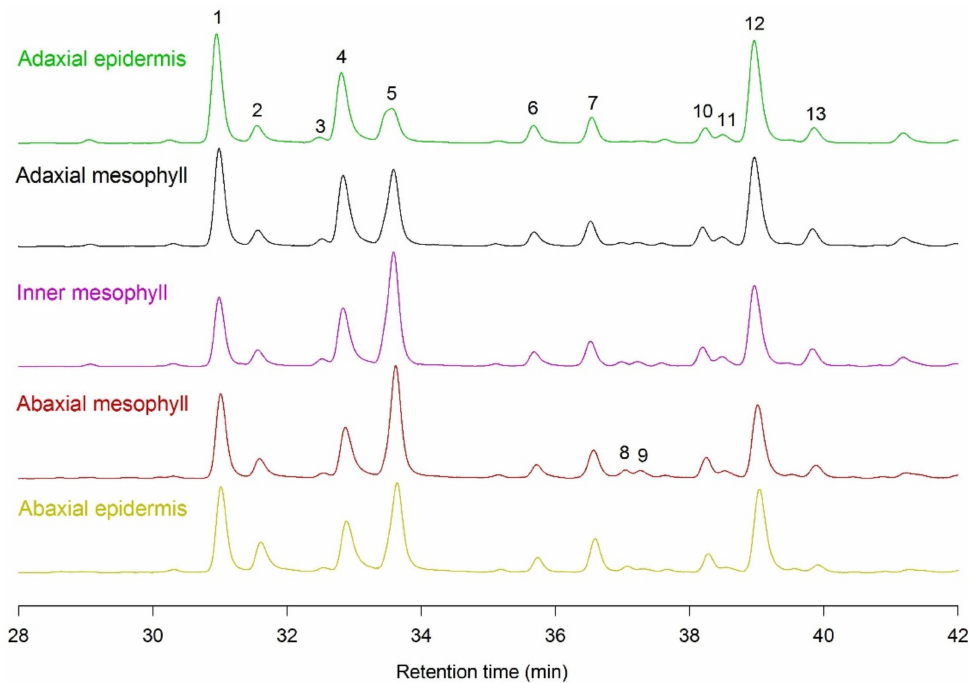
Figure 5. Representative chromatograms (at 310 nm) showing the phenylpropanoid profile of individual tissues (adaxial epidermis—green; adaxial mesophyll—black; inner mesophyll—purple; abaxial mesophyll—red; abaxial epidermis—yellow) of P. latifolia leaves sampled during the